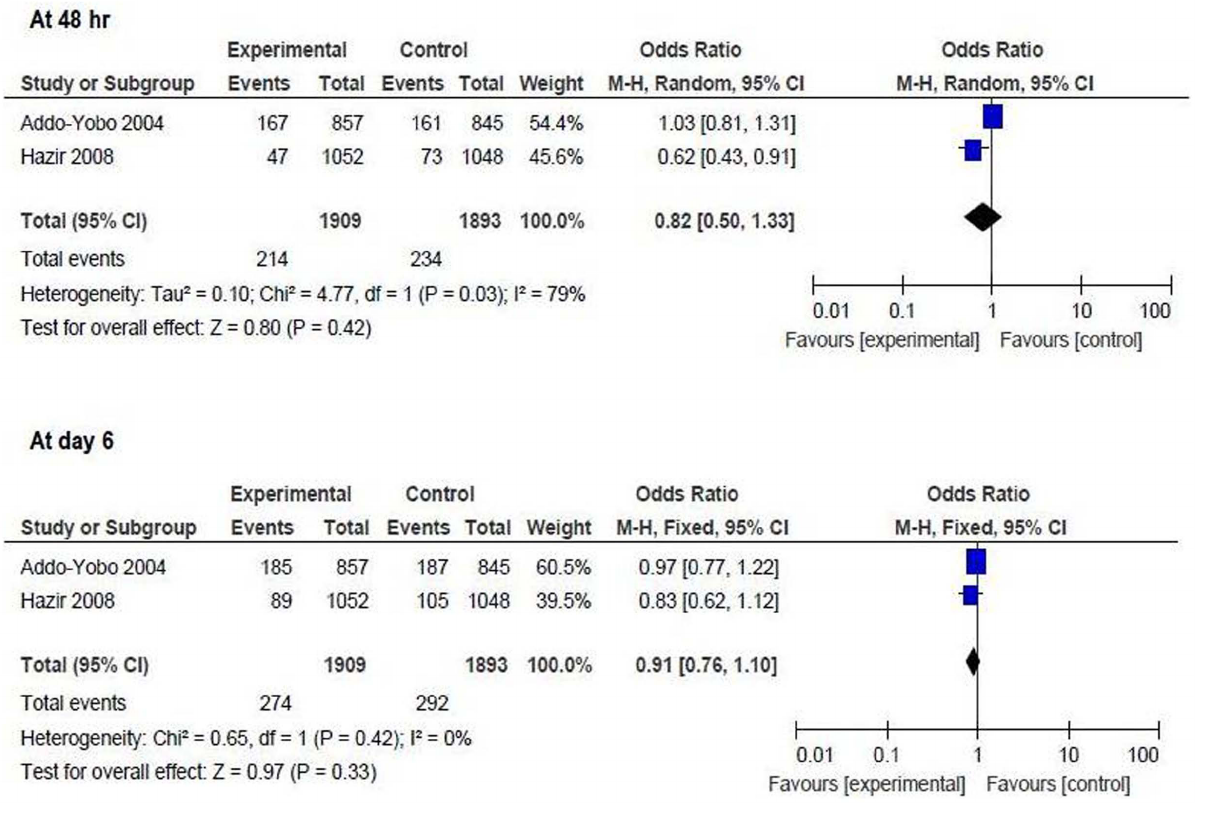
Figure 2. Primary outcome measures [oral amoxicillin versus injectable antibiotics]. Proportion of children developing treatment failure at 48 hr and at day 6.